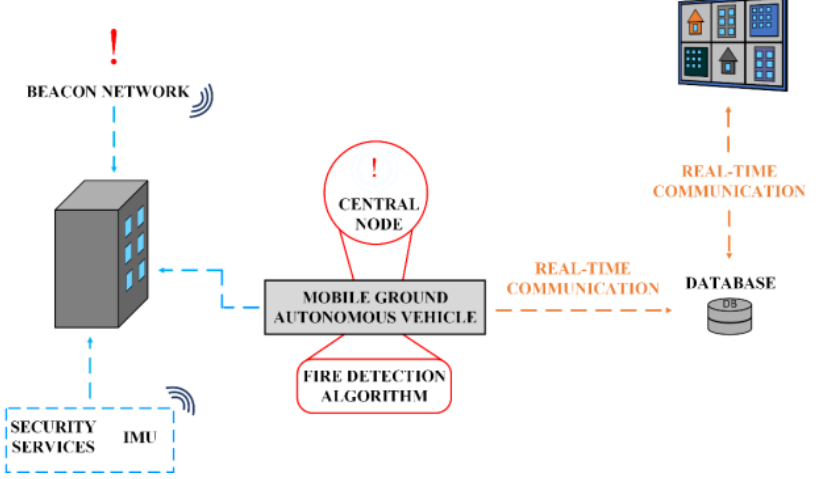
Figure 11. Model of the proposed indoor monitoring system